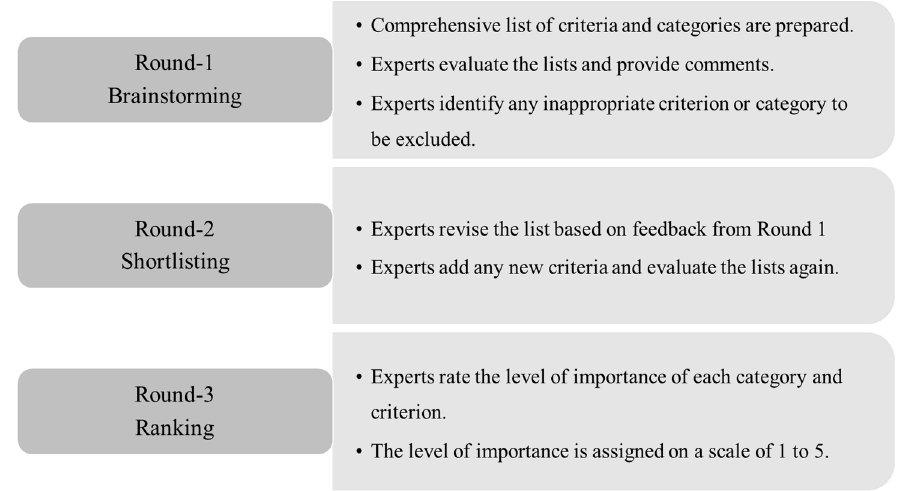
Figure 5. A Typical Delphi Technique Process.